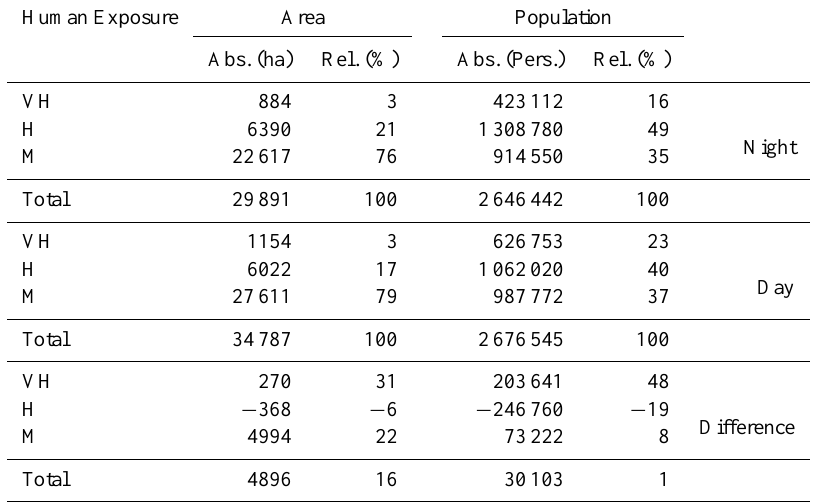
Table 4. Total surface and population in each human exposure class in nighttime and daytime periods in the study area. Human Exposure Area Population Abs. (ha) Rel. (%) Abs.